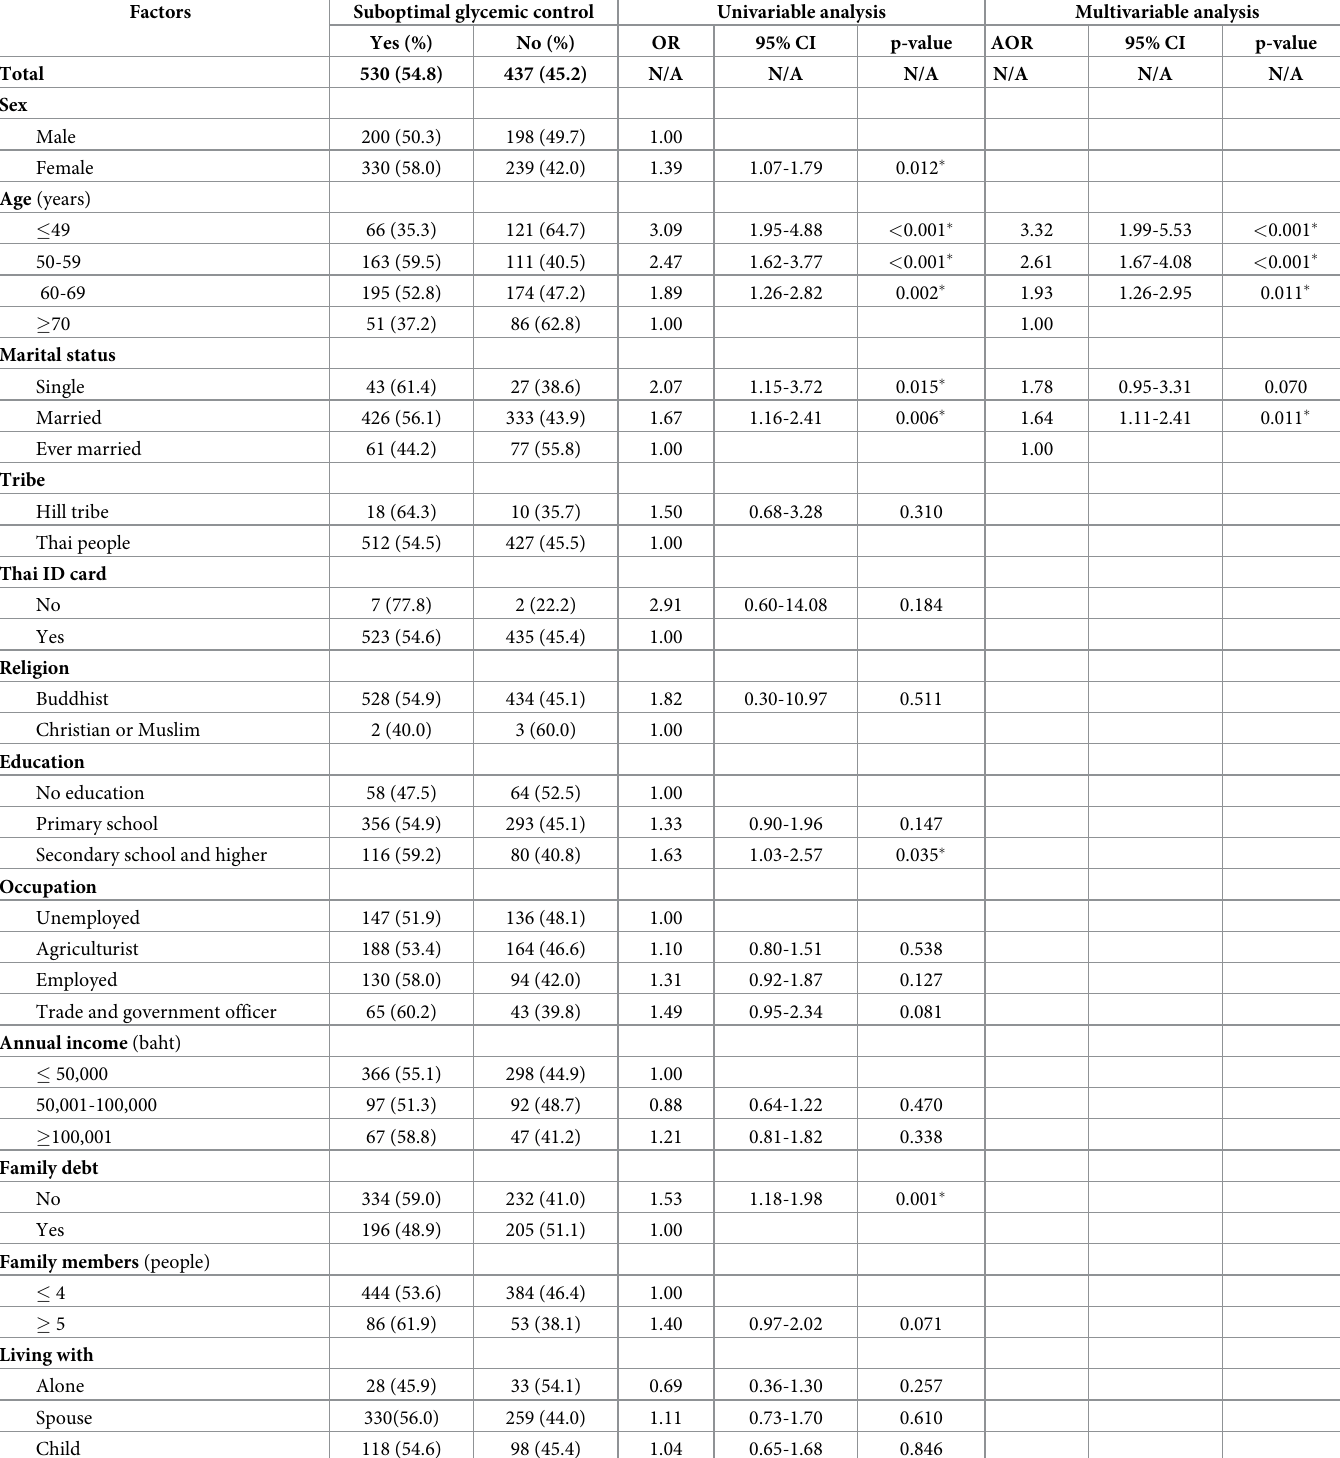
Table 4. Identifying socio-demographics that associated with suboptimal glycemic control among DM patients by univariable and multivariable logistic regressions.